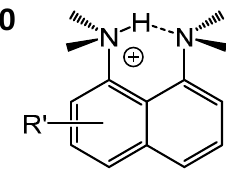
Figure 9. Schematic structure of protonated proton sponge 10 , studied by NMR in [86].